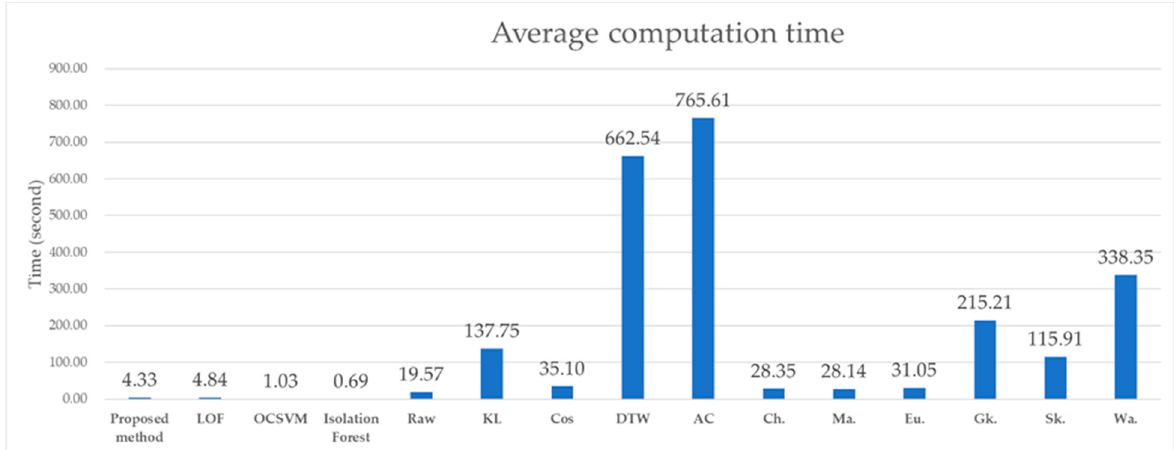
Figure 5. Average computation time. LOF: local outlier factor, OC-SVM: one-class support vector machine, iF : isolation forest, KL: Kullback-Leibler, Cos: cosine dissimilarity, DTW: dynamic time warping, AC: autocorrelation, Ch.: Chebyshev norms, Ma.: Manhattan norms, Eu: Euclidean norms, Gk: Gaussian kernel, Sk.: Sigmoid kernel, Wa.: Wasserstein distance.